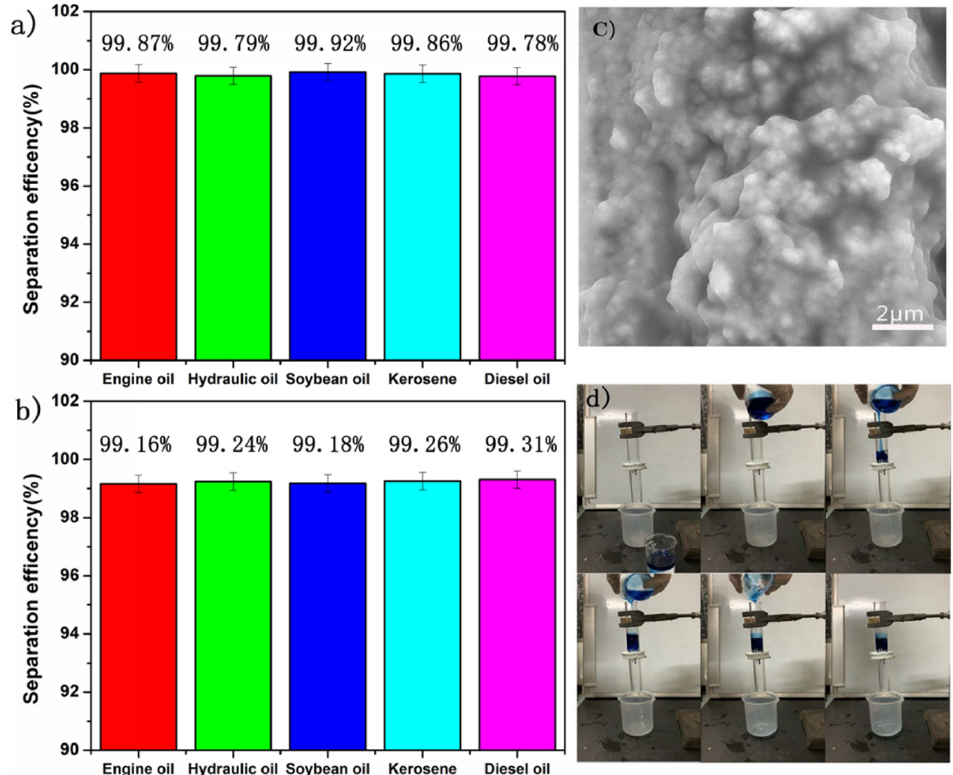
Figure 4. The separation efficiency of different oil/water mixtures ( a ) before and ( b ) 50 separation cycles SEM image ( c ) of SiO 2 -Na 2 SiO 3 -coated SSF after 50 separation cycles with the separation process ( d ).